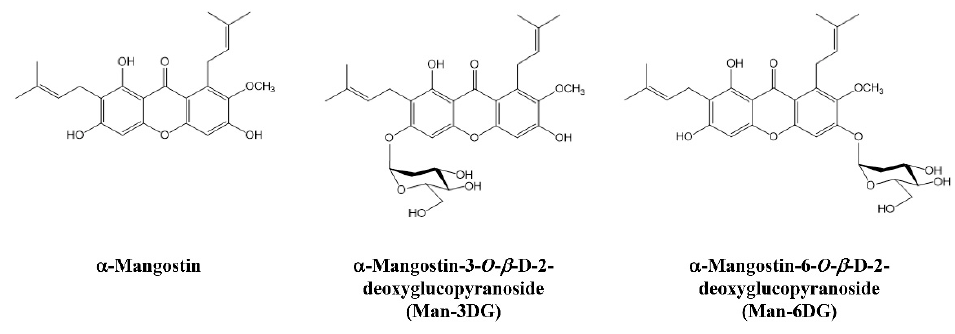
Figure 1. The chemical structures of α -mangostin and α -mangostin glycosides.